Question: What kind of plot is shown here?
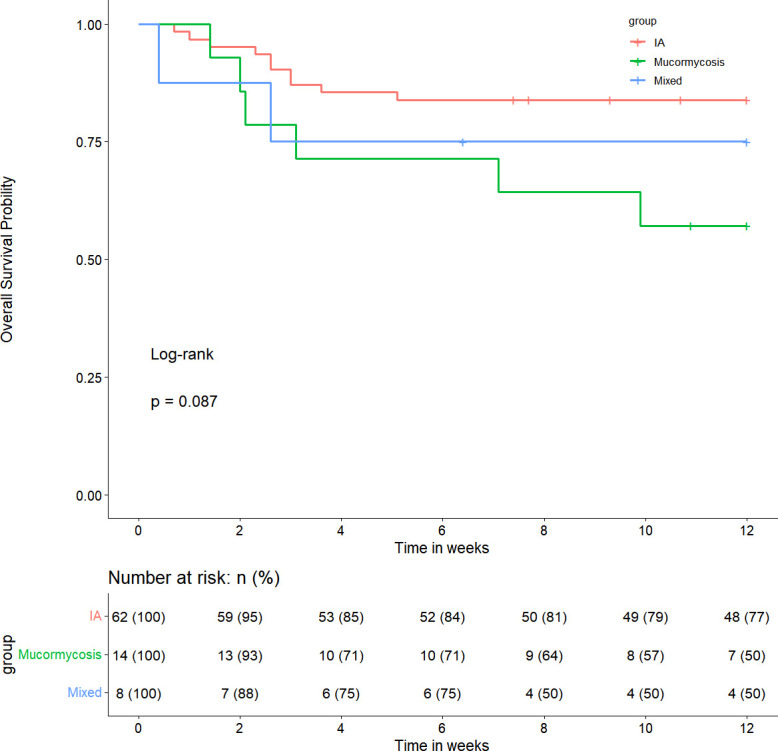
Answer: survival